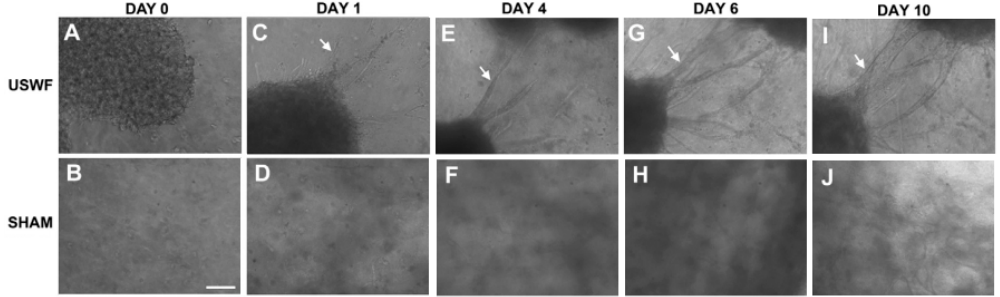
Figure 7. Phase-contrast images of neovessel formation and sprout in suspended endothelial cells in an unpolymerized collagen type-I solution following ultrasound standing wave field (USWF) exposure ( A , C , E , G , I ) shown by white arrow and sham-exposed ( B , D , F , H , J ) in scale bar of 100 μ m, courtesy of [76]. Molecules 2016 , 21 , 590